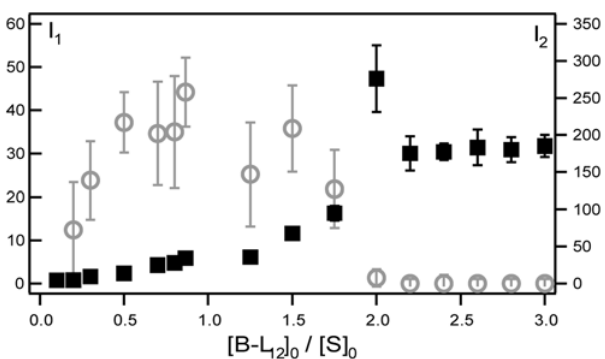
Figure 3. Determination of the number of interaction sites of the streptavidin: Variation of intensities of the free and bound streptavidin with the molar ratio r. The graph shows the behavior of intensities I 1 (grey circles) and I 2 (black squares) as a function of the molar ratio r =[B-L 12 ]/[S]. I 1 represents the intensity of the signal corresponding to the diffusion coefficient D 1 =3.2 m m 2 s 2 1 whereas I 2 refers to the intensity of the signal corresponding to the D 2 =1.6 m m 2 s 2 1 diffusion coefficient. This graph reflects the stoichi- ometry of the corresponding proteins species. The first species is characterized by a small and broad peak centered around 1 that suggests that streptavidin is bound to one biotinylated peptide. The intensity of the second species increases as r increases to reach a plateau at r =2 which suggests a stoichiometry of two biotinylated peptides per streptavidin.